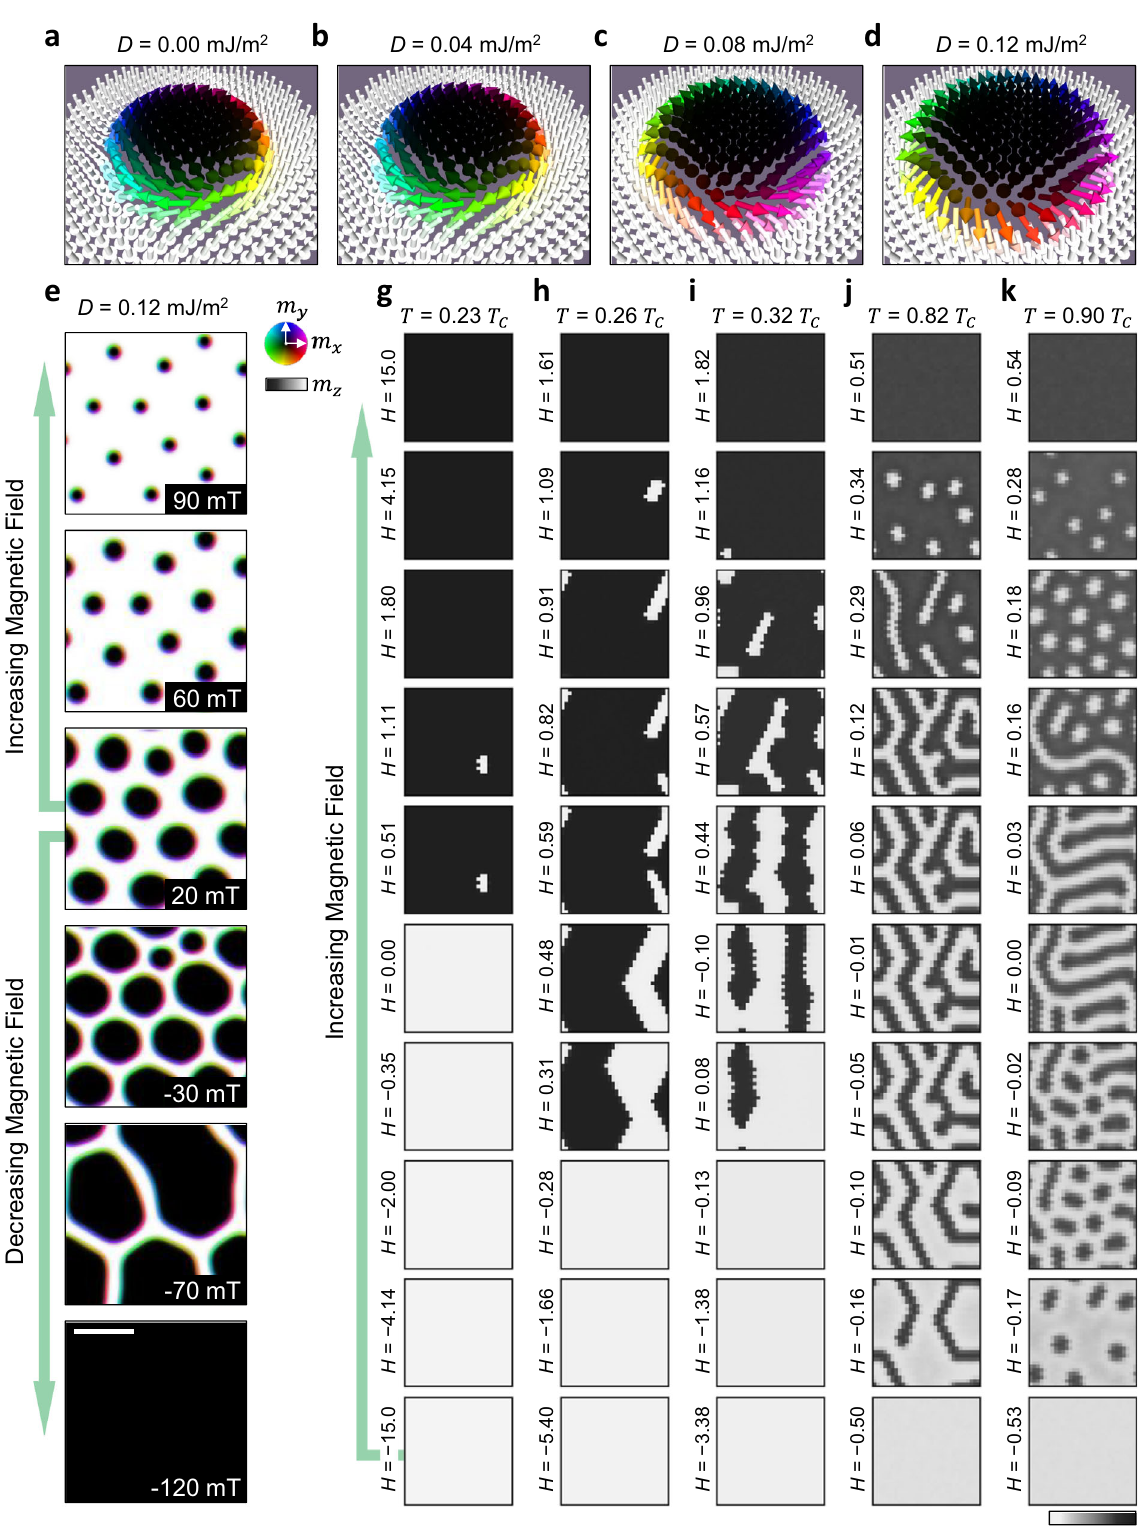
Fig. 6 Micromagnetic and mean- fi eld simulations. a – d Visualisations of micromagnetic simulations showing the change in skyrmion helicity from Bloch- type to Néel-type with increasing Dzyoloshinskii-Moriya interaction strength, D . e Visualisations of micromagnetic simulations showing the evolution in size and shape of skyrmions initialised at 20 mT for both increasing and decreasing magnetic fi eld. The scale bar is 100 nm. g – k Mean- fi eld simulations of the magnetic domain structure evolution following the fi eld sweep procedure for increasing applied fi eld, H , at different temperatures, utilising the model with increased anisotropy scaling at lower temperatures. The colourwheel and colourbars indicate the in-plane and out-of-plane magnetisation,